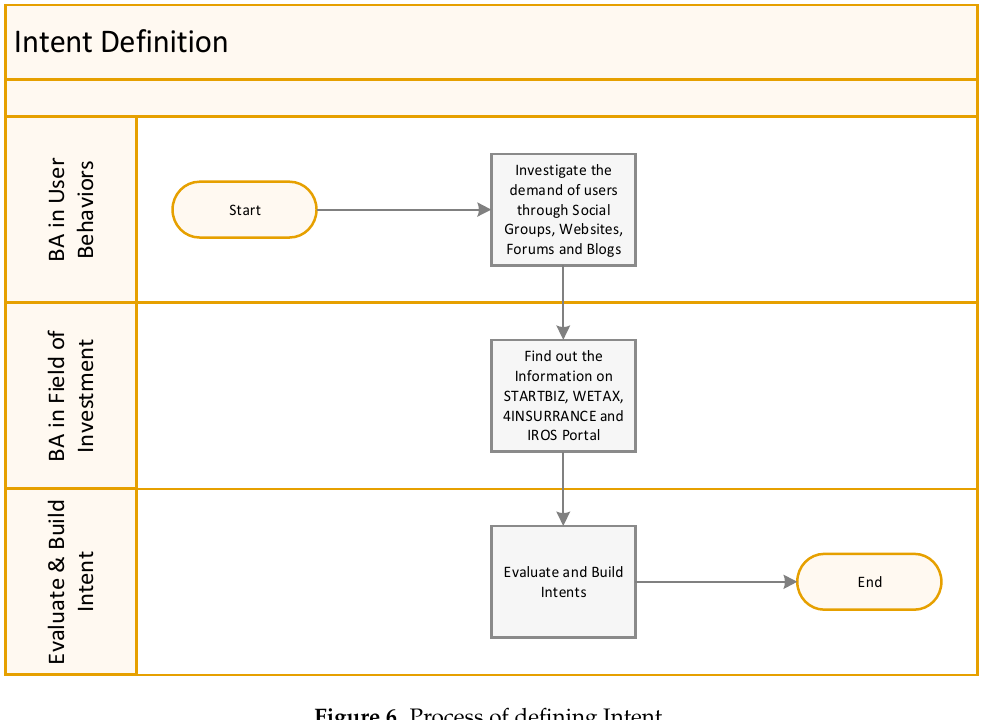
Figure 6. Process of defining Intent.